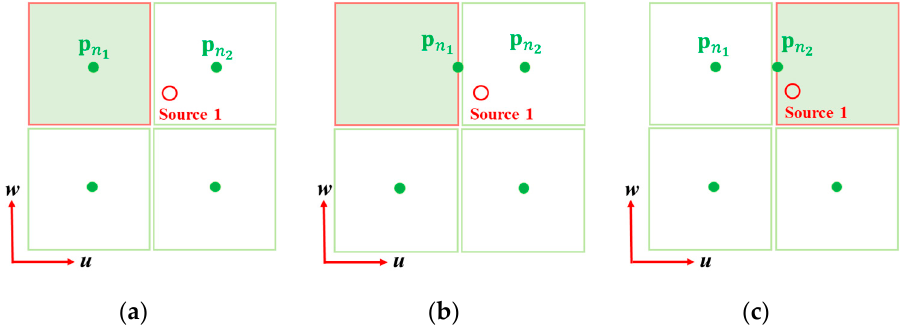
((cid:2868)) and ( 0 ) Figure 3. Grid activation and transfer process. ( a ) 𝐩 (cid:3041) (Left-top grid) is initially located at 𝐩 (cid:3041) Figure 3. Grid activation and transfer process. ( a ) p p (cid:3117) (cid:3117) n 1 and the n 1 (Left-top grid) is initially located at the grid is activated. ( b ) After some iteration, 𝐩 (cid:3041) approaches to the off-grid cavitation and is cap- grid is activated. ( b ) After some iteration, p n approaches to the off-grid cavitation and is captured at (cid:3117) 1 tured at 𝑢 (cid:3041)(cid:2878) . ( c ) 𝐩 (cid:3041) is transferred to 𝐩 (cid:3041) (Right-top grid) and the 𝐩 (cid:3041) is inactivated. 𝐩 (cid:3041) inherits the u n + . ( c ) p p p p p (cid:3117) (cid:3118) (cid:3117) (cid:3118) n 1 is transferred to n 2 (Right-top grid) and the n 1 is inactivated. n 2 inherits the n 1 and 𝐩 (cid:3041) and the grid is activated. (cid:3117) the grid is